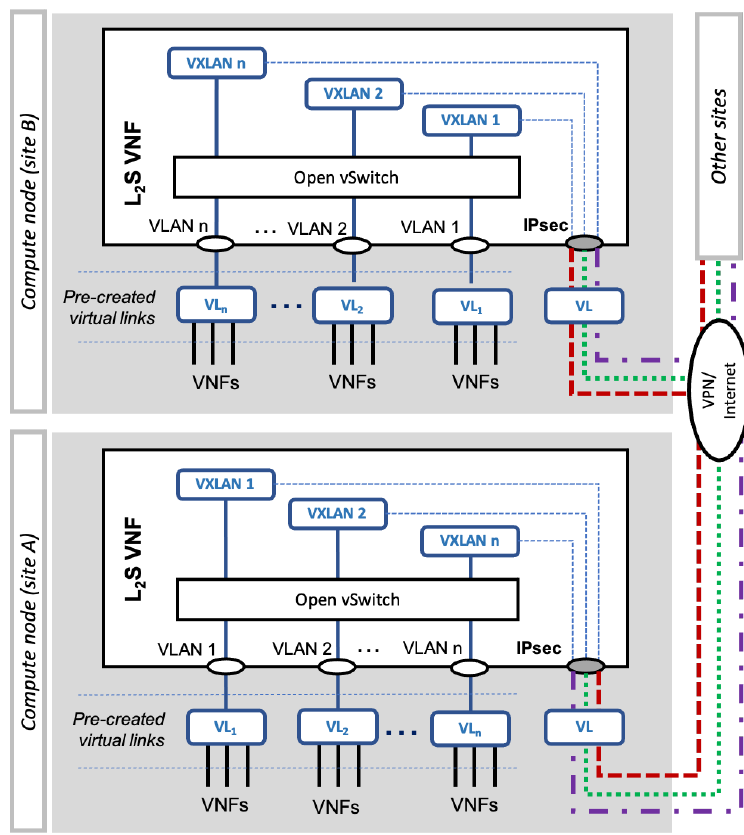
Figure 3. Implementation of the L 2 S